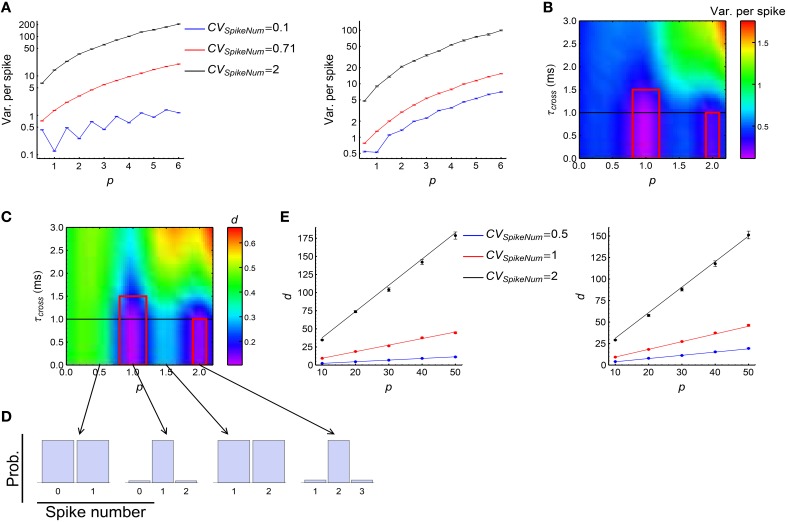
The influence of synchronous firing onto DiffV and the contribution of d. (A) Variance per spike (ET[Vara(Δwa)]∕N¯0, see Equation 10) as a function of p under different CVSpikeNum values for τcross = 0.5 ms (left) and τcross = 2.5 ms (right), when spike trains are generated according to Model Sync (see Section 2). The efficacy variances span a large range, so here we use log scale to better show their changes. (B) Variance per spike as a function of p and τcross when CVSpikeNum = 0.1. Note the reduction of variance per spike in the red squares. The black horizontal line represents the axonal delay τdelay = 1 ms. (C)
d as a function of p and τcross when CVSpikeNum = 0.1. Note the reduction of d in the red squares. (D) The distribution of spike number per neuron per synchronous event under different p values indicated by the starting points of the arrows, when CVSpikeNum = 0.1. Note that the distribution peaks at p when p is an integer. (E) Comparison of the numeric results (dots with error bars) of d with the analytic results (solid lines) given by Equations 28 and 29 for τcross = 0.5 ms (left) and τcross = 2.5ms (right). In (A–E), the size of the converging motif, the parameters for STDP as well as the simulation time and trials are the same as in Figure 4. Error bars represent s.e.m.